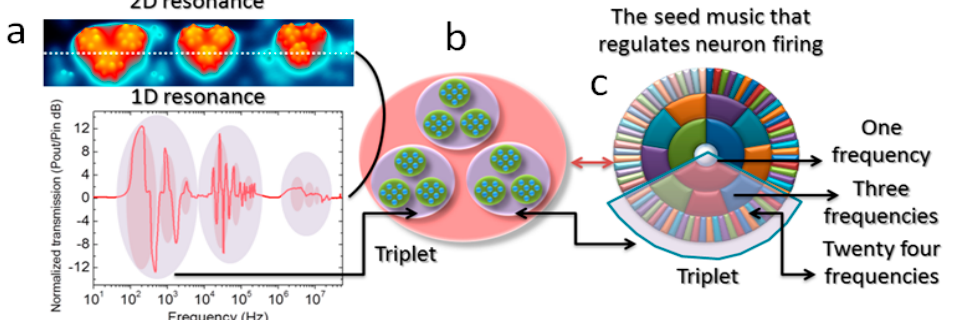
Figure 5. Frequency wheel for the triplet–triplet resonance band (Movie 1): ( a ) 2D resonance of a single isolated microtubule from Figure 3a. A dotted line shows 1D resonance measurement location (top), the data are shown below panel (a). The 3D resonance plot of panel a is represented as a nest of nine circles (nine circles inside three circles inside one circle = 13 circles). Using a shadow and an arrow we connected a triplet in a 1D resonance plot of panel (a), with the schematic of panel ( b ); ( c ) The circular triplet–triplet plot of panel b is a replica of experimental resonance data (panel a), however, the resonant oscillations follow a periodic condition. If we apply periodic limits then panel b looks like panel c. One can find the triplet in panel c, each triplet has single frequency and its total period is sum of three frequencies inside, each of the three has periods of eight frequencies (a particular case of